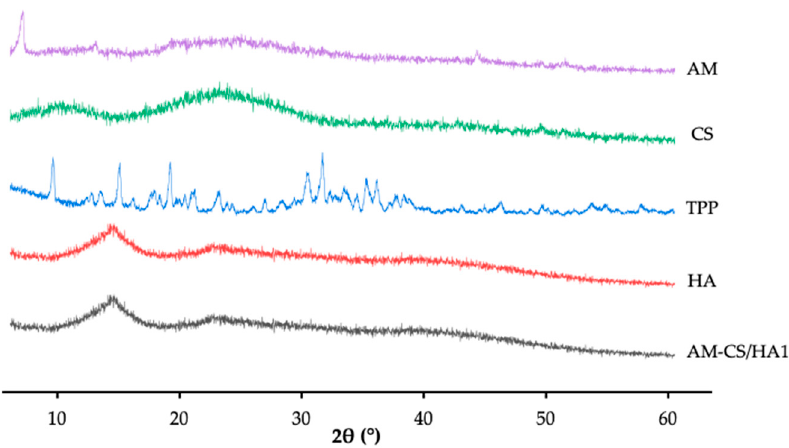
Figure 3. XRD patterns of raw material and AM-CS/HA1.